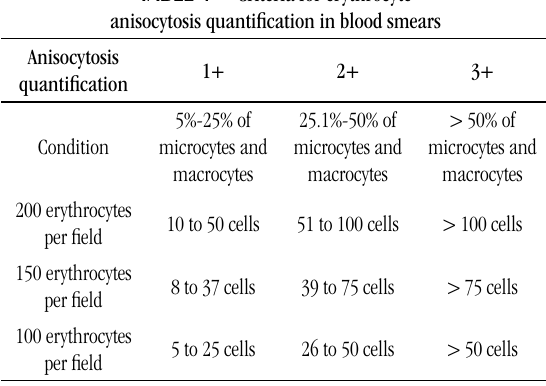
tABLE 1 – Criteria for